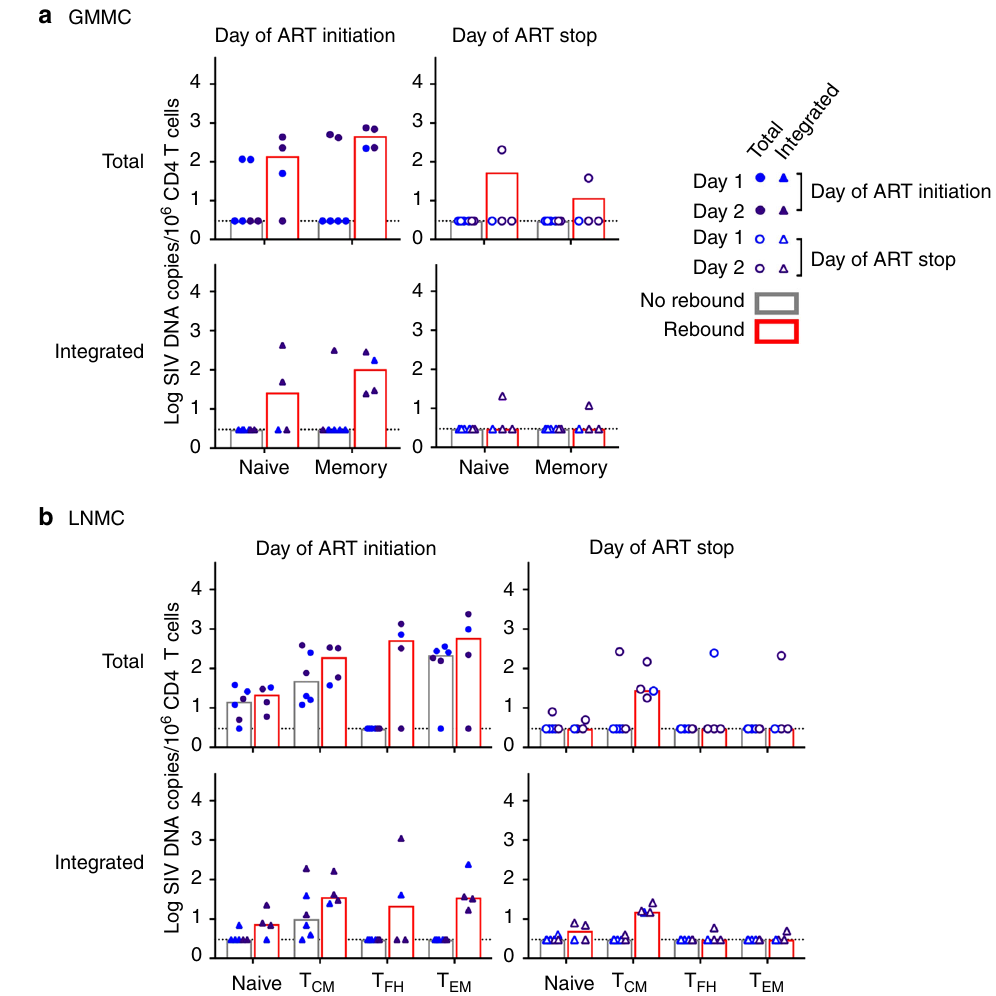
Fig. 4 Comparison of integrated SIV DNA in CD4 + T cell subsets following ART discontinuation. a Total and integrated levels of SIV DNA in sorted naive and memory CD4 + T cells in GMMC and b naive, central memory (T CM ), follicular helper (T FH ) and effector and effector memory (T EM ) CD4 + T cells in LNMC are shown. Ten animals that initiated ART on day 1 ( n = 5) or 2 ( n = 5) were divided into two groups: animals that did not rebound ( n = 6) and animals that did rebound ( n = 4) following ART withdrawal. All data points are shown. Bars indicate the median of values. p values re fl ect Fisher ’ s exact test to compare the frequency of the SIV DNA positive sample distribution between each